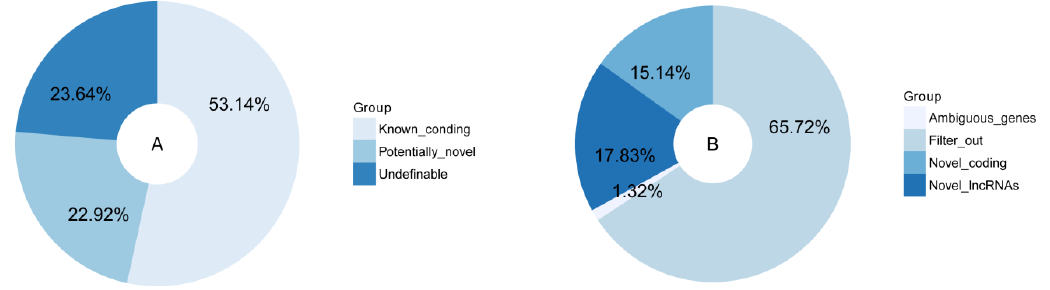
Figure 3. Classification of reconstructed transcripts ( A ) and results from CNCI ( B ).